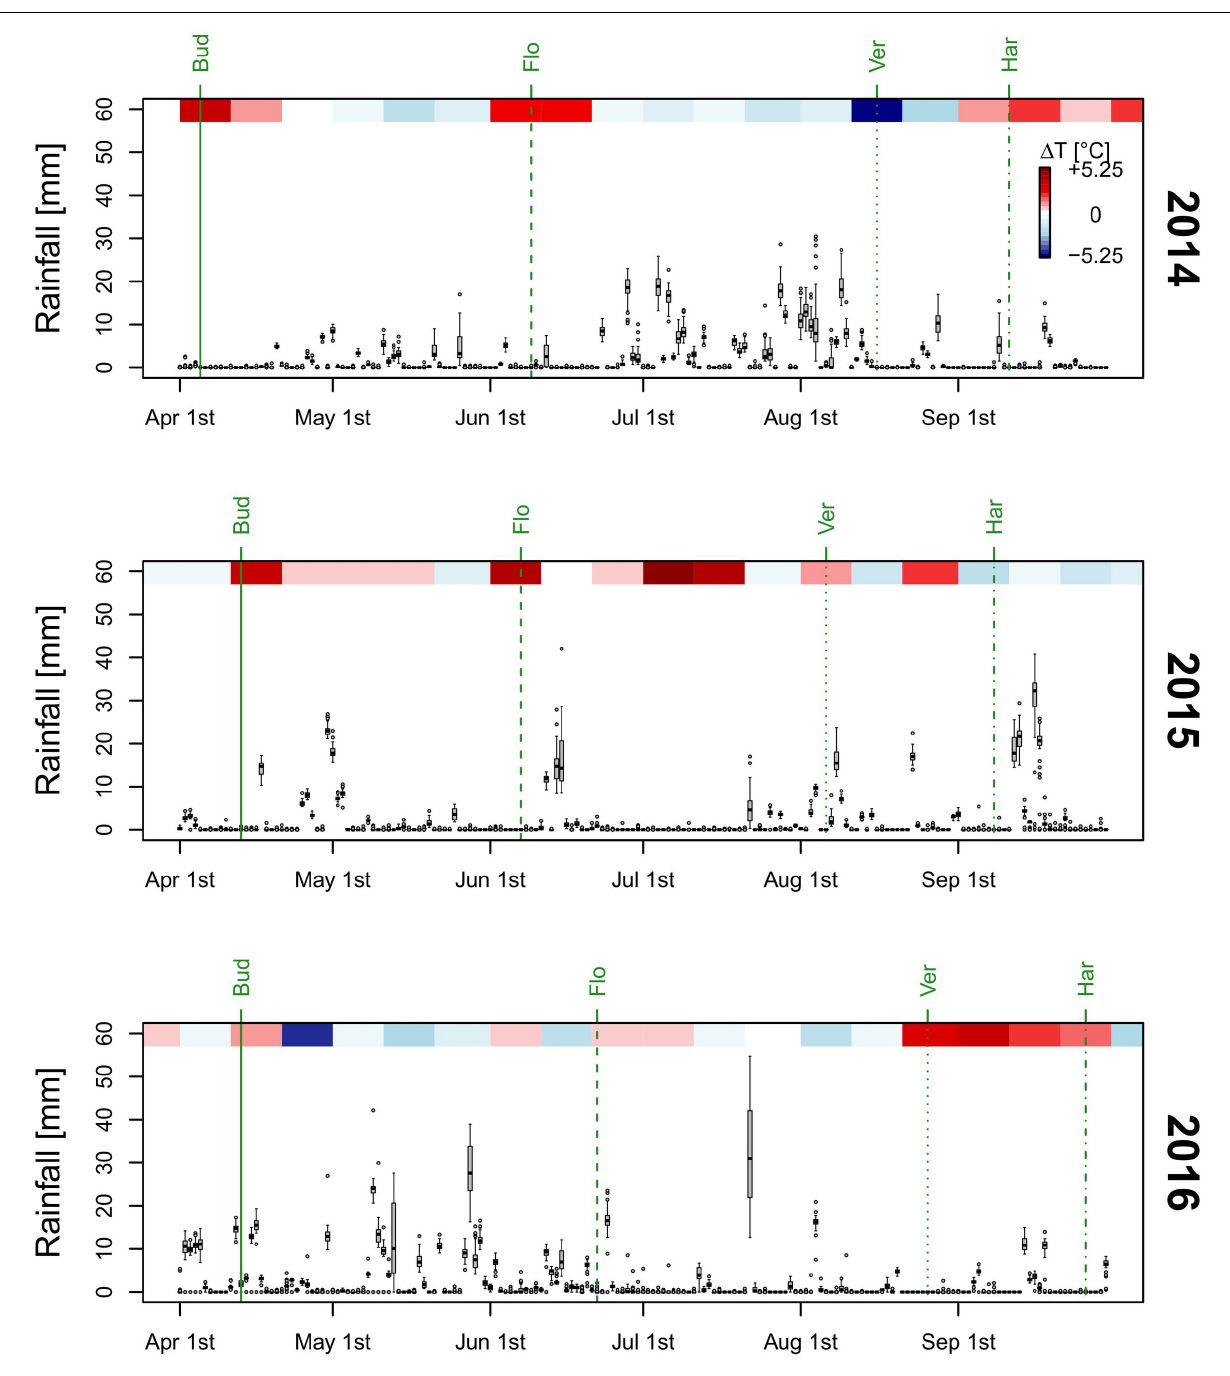
FIGURE 2 | Daily rainfall variability. Each box plot shows the distribution of daily rainfall collected by 45 rain gauges. The colored bar on the top of each plot indicates the anomaly in average temperature [ (cid:49) T ( ◦ C)] per decade (i.e., 10 days) in comparison to the 1986–2015 decade average, from Beaune weather station (red dot on Figure 1C